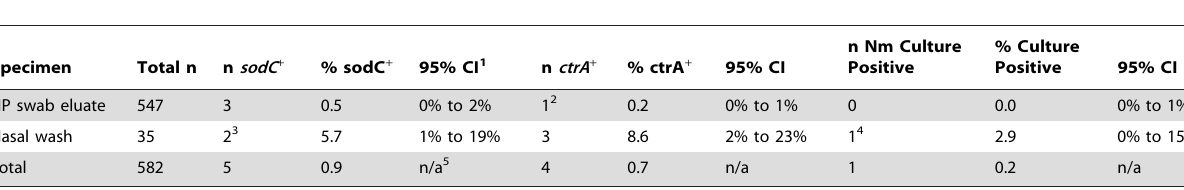
Table 5. Carriage specimens tested for sodC and ctrA and compared to culture.